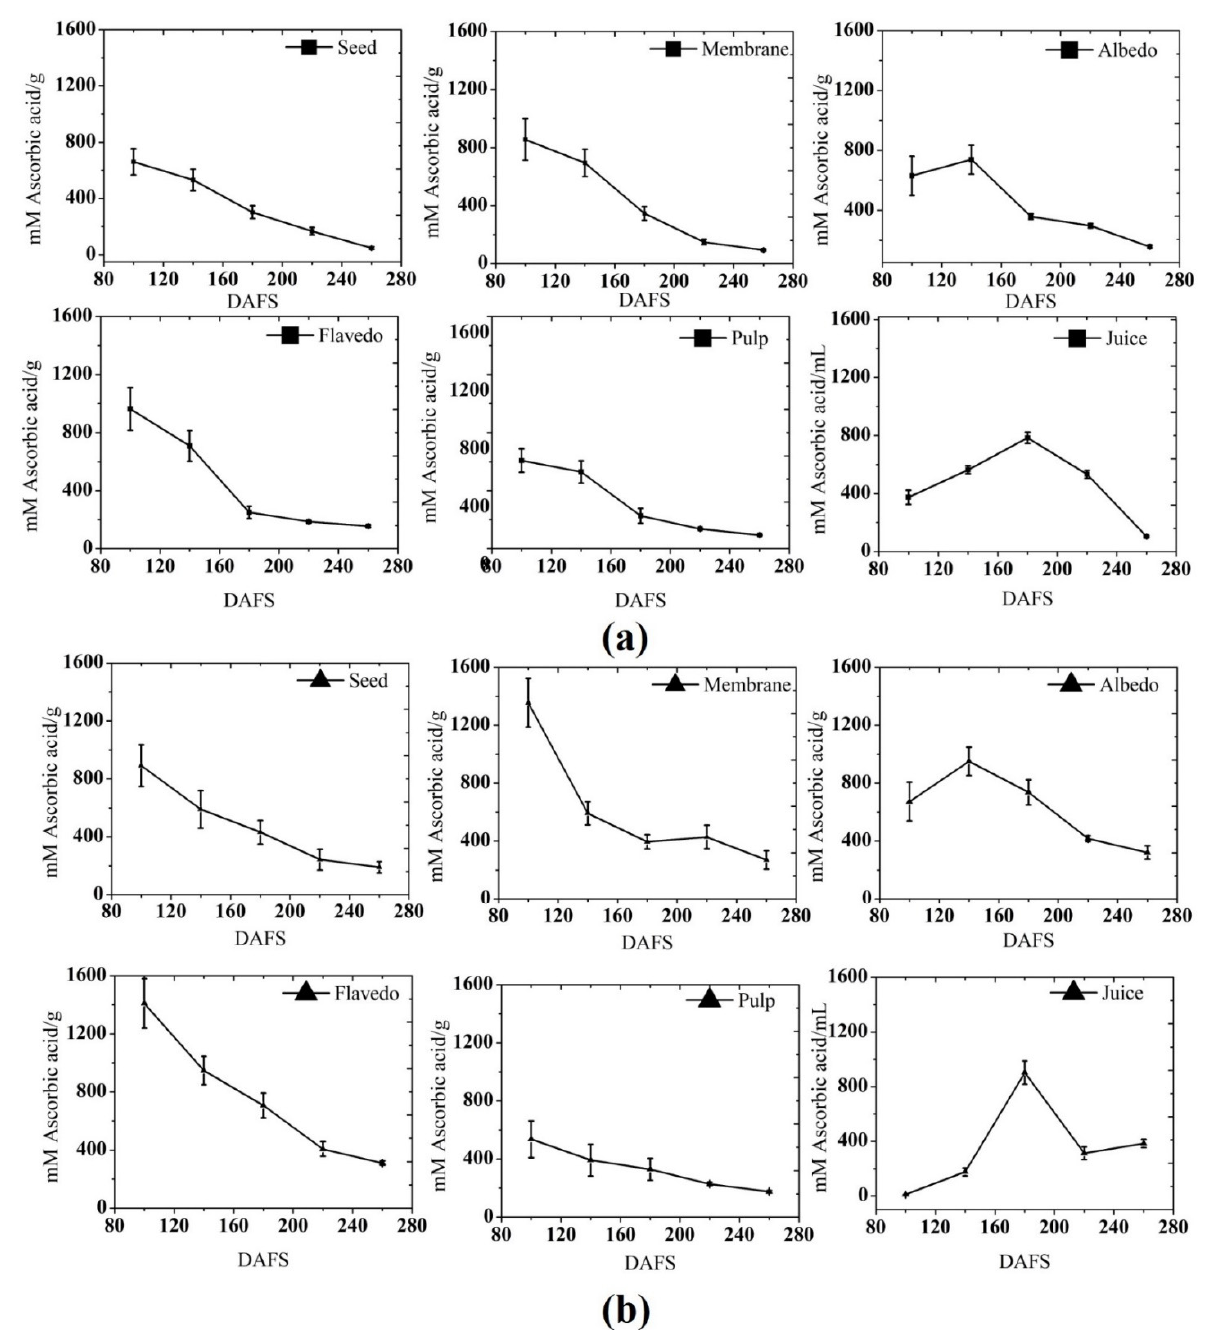
Figure 7. Antioxidant capacity by the phosphomolybdenum method in ( a ) 2018; and ( b ) 2019. DAFS: days after fruit set.